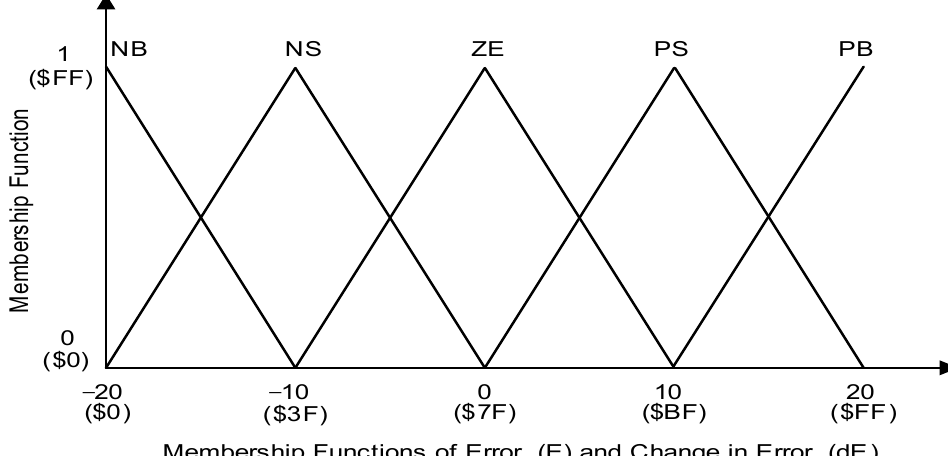
Figure 5. Membership Function (MF) of Error (E) and Change in Error (dE) with digital scaling format. The input MFs are Negative Big (NB), Negative Small (NS), Zero (ZE), Positive Small (PS) and Positive Big (PB).